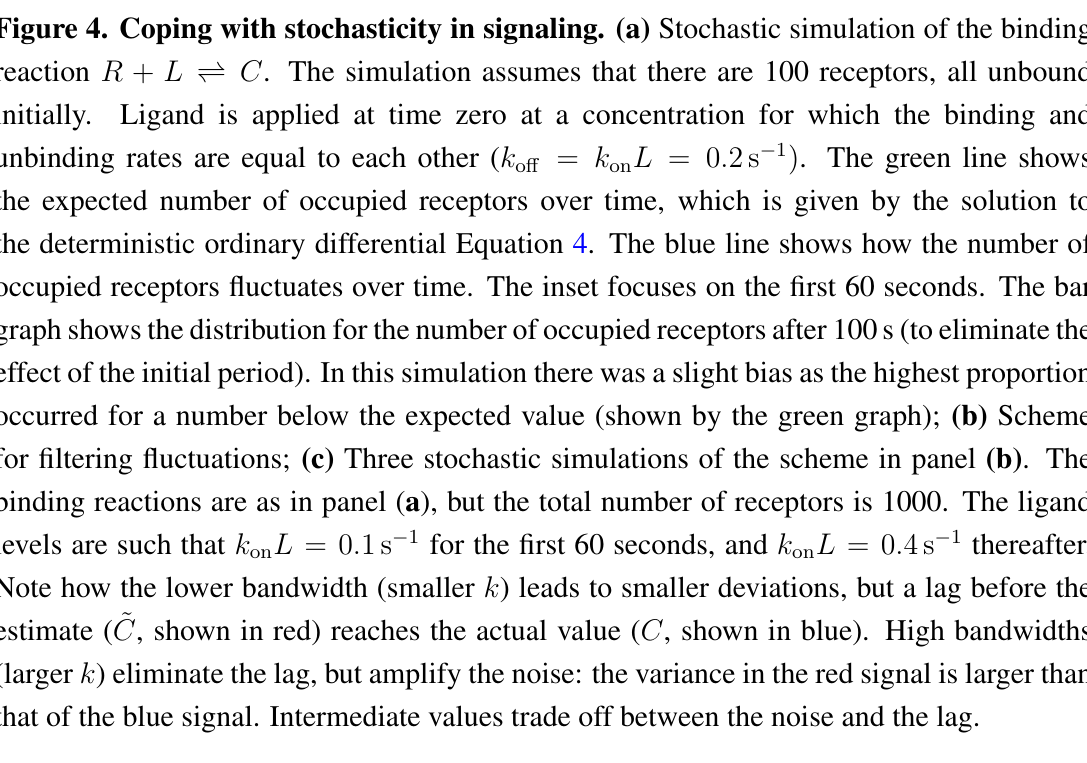
Figure 4. Coping with stochasticity in signaling. (a) Stochastic simulation of the binding reaction R + L (cid:42)(cid:41) C . The simulation assumes that there are 100 receptors, all unbound